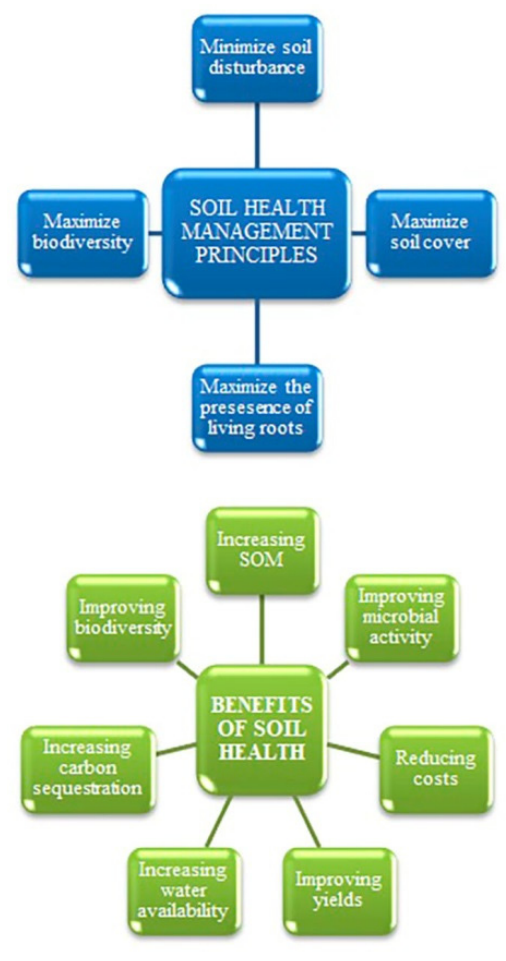
Figure 3. Management principles and benefits of soil health.